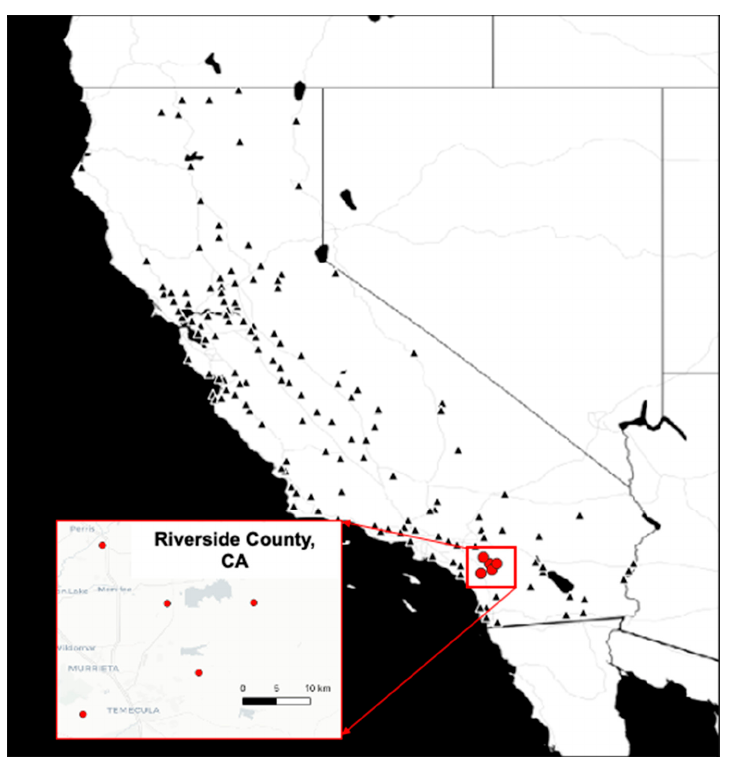
Figure 1. California Irrigation Management Information System (CIMIS) station locations used by Eastern Municipal Water District in Southwest Riverside County, CA. Black triangles represent 155 CIMIS stations in California; red circles represent the stations used in this study.